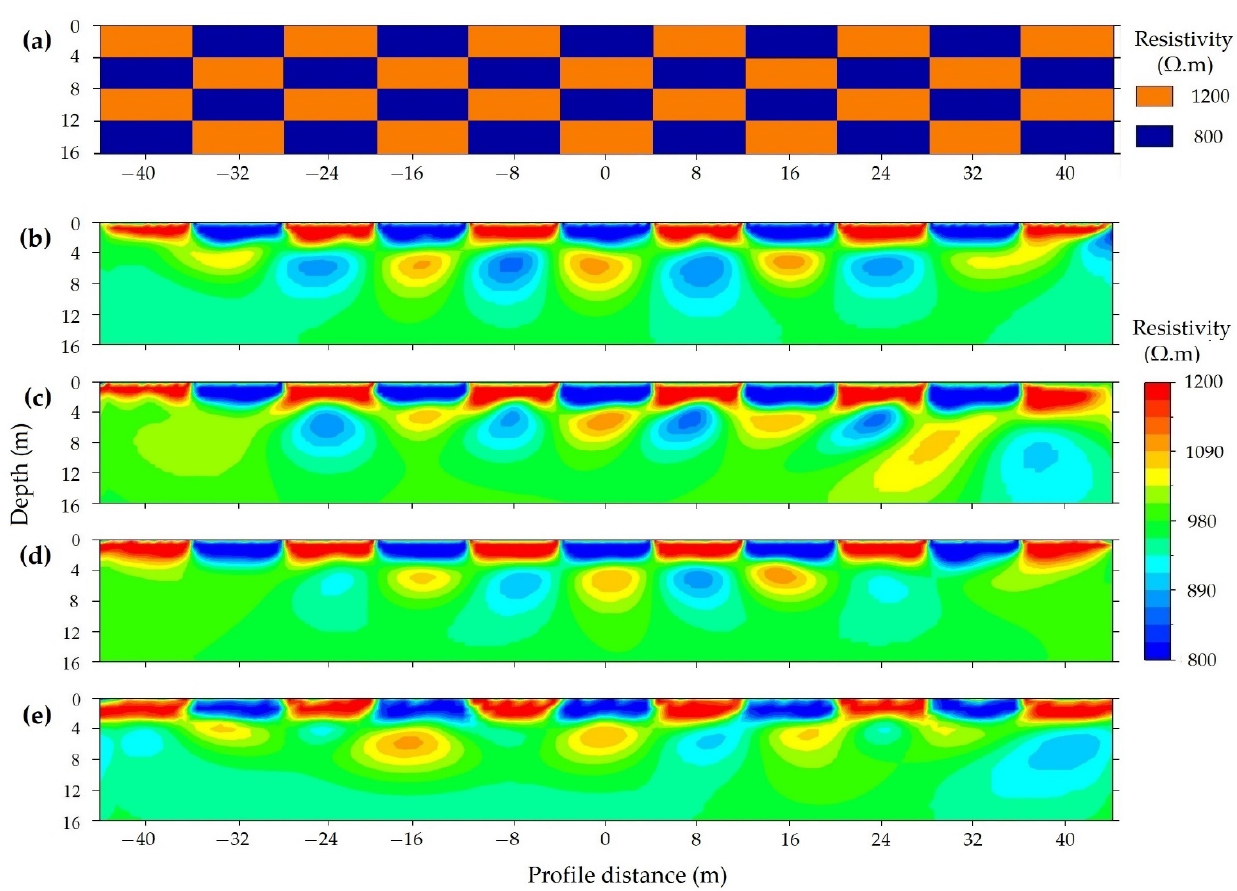
Figure 25. Scenario 3 spatial resolution test for the 4 m (vertical) × 8 m (horizontal) checkerboard cell sizes. ( a ) Checkerboard model, ( b ) DD array, ( c ) PD array, ( d ) WS array, ( e ) PP array.